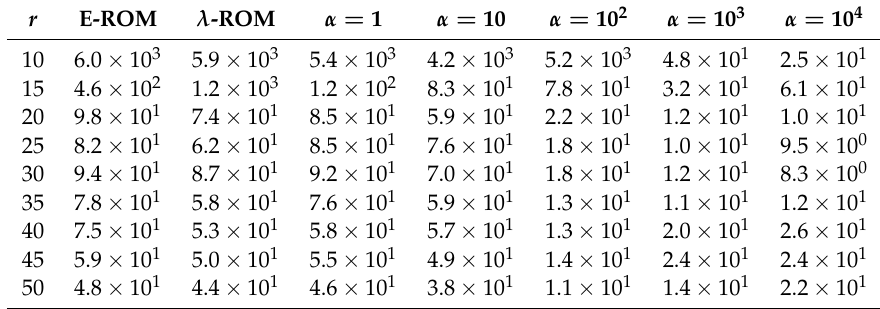
Table 4. Lagrangian investigation, reconstructive regime: L 2 norm of the errors in the time-averaged FTLE (23) for E-ROM (second column) λ -ROM (third column), and α -ROM for α = 1 (fourth column), α = 10 (fifth column), α = 10 2 (sixth column), α = 10 3 (seventh column), and α = 10 4 (eighth